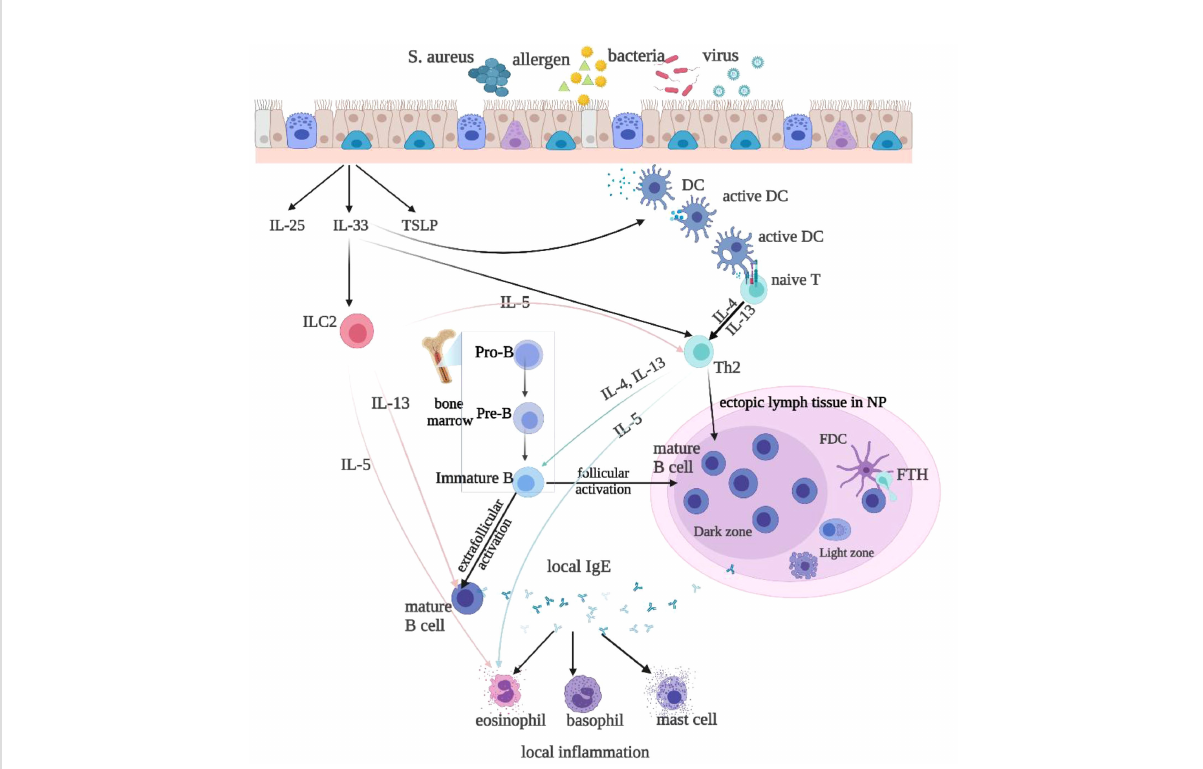
FIGURE 1 Local IgE is produced by follicular and extrafollicular activated B cells through class switch recombination. Microbial colonization, such as bacteria, rhinovirus, and allergens, especially the superantigen Staphylococcus aureus(SA), stimulate local IgE formation. The T follicular helper (Tfh) cells and Th2-like cells are helper cells for the B cell class switching to IgE. The Th2 cytokines IL-4 and IL-13 stimulate class switching to IgE and IgE formation. Type 2 innate lymphoid cells(ILC2s) produce Th2 cytokines, such as IL-4, IL-5, and IL-13, to promote type 2 in fl ammation, upon stimulation with epithelium-derived cytokines, such as IL-25, IL-33, and thymic stromal lymphopoietin(TSLP). IL-33 also activates DCs, which may via superantigens prime naive T cells to develop into Th2 cells. IL-4 and IL-13 then activate B-cells and initiate local IgE production. IL-5 released by ILC2s or Th2 cells activate